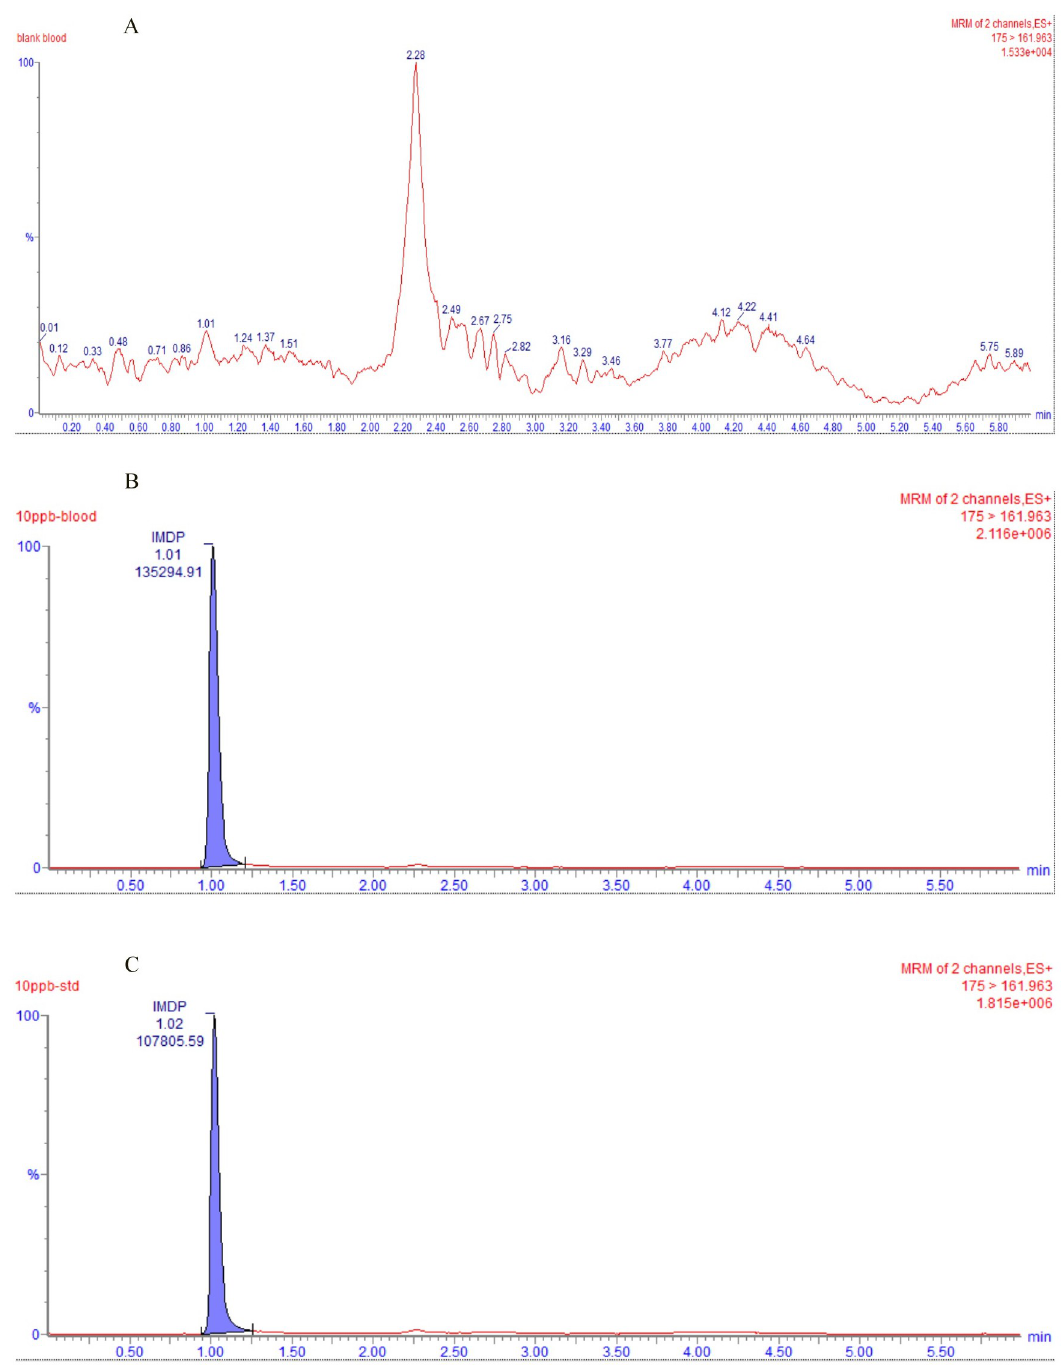
Fig 1. UPLC-MS/MS chromatograms. (A) blank plasma sample, (B) blank plasma sample spiked with IMD (10 ng/mL), (C) 10 ng/ mL standard IMD solution.